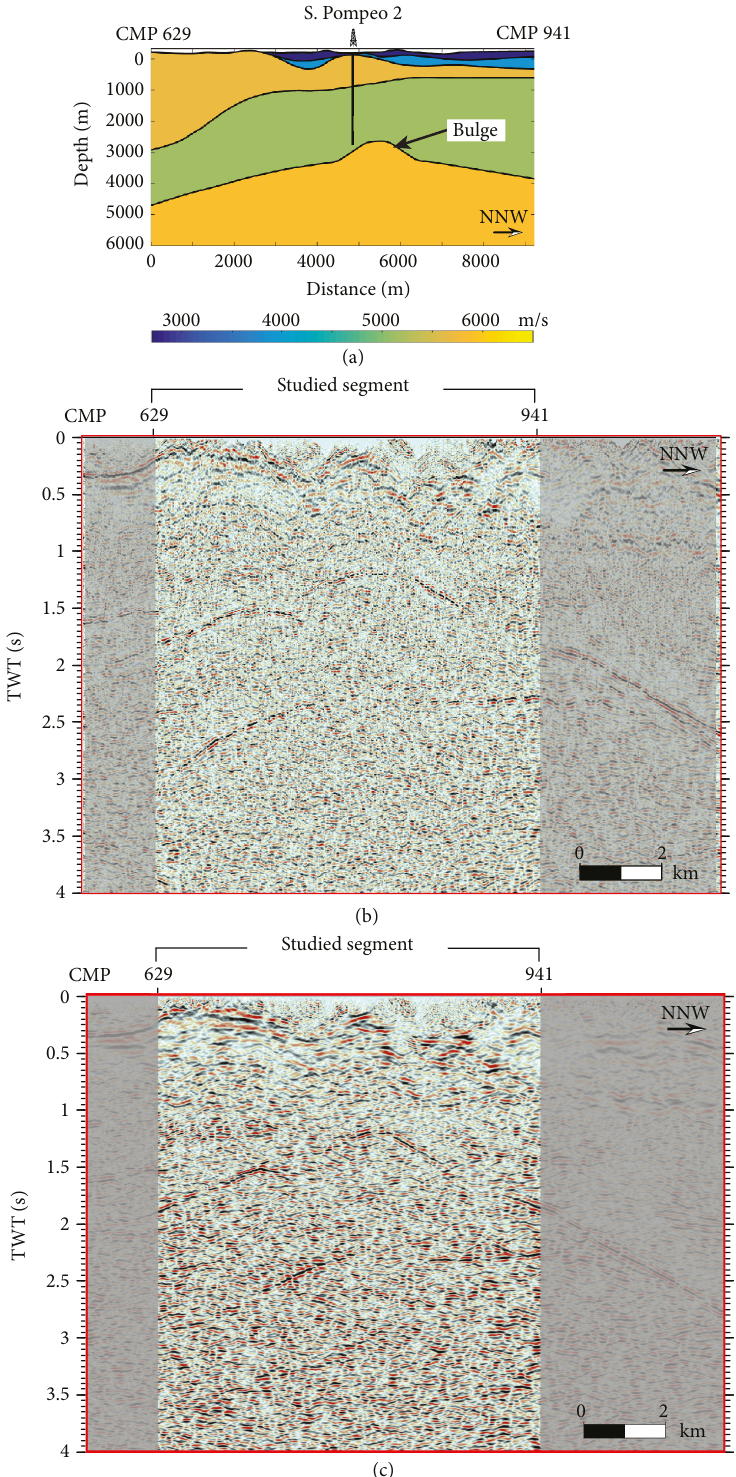
Figure 11: (a) Velocity model, named model 2-B (see Figure 10(b)). (b) Studied segment of the CROP-18A stacked section (see Figure 6(b)). (c) The fi gure shows the time-migrated section of the CROP-18A data, reported in Figure 11(b), obtained through the calibrated